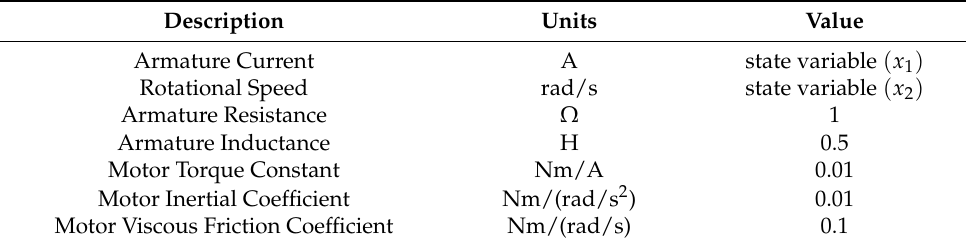
Table 5. Parameters of DC